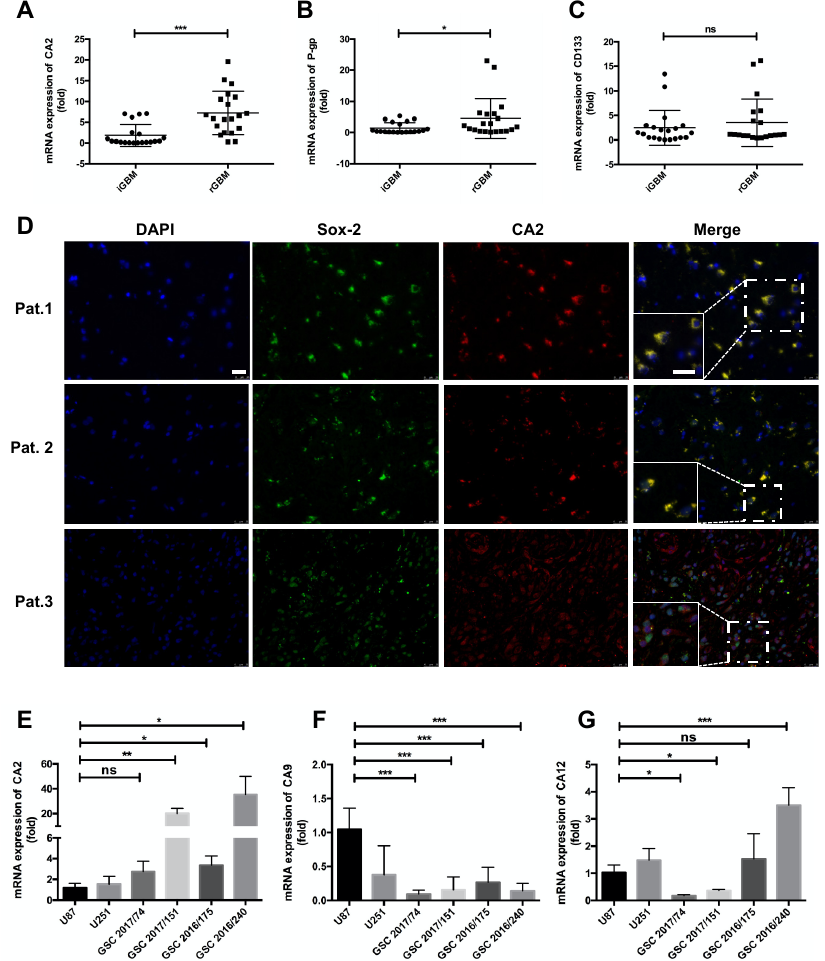
Figure 1. Expression levels of CA2 ( A ), P-gp ( B ), and CD133 ( C ) in patient-matched initial (i) vs. recurrent (r) GBM ( n = 20 from 10 matched patients); ( D ) Representative IF staining of CA2 and stem cell marker SOX2 in three GBM tissue sections. Co-staining of CA2 (red) and SOX2 (green) confirmed CA2 in stem-like cells of GBM patients ( n = 3 from 10 recurrent GBM patients), scale bar: 25 μ m. ( E – G ) mRNA expression of GBM related carbonic anhydrase genes CA2 ( E ), CA9 ( F ), and CA12 ( G ) in GBM cell lines U87 and U251 and patient-derived GSCs. Carbonic Anhydrase expression levels were detected by qPCR ( n = 3). For all genes, expression levels determined in U87 cells were set to 1. qPCR results were obtained from three independent experiments. In ( A – C , E – G ), data are presented as mean ± SD, student’s t -test was used to analyze ( A – C ), One-way ANOVA was used to analyze ( E – G ), * p < 0.05; ** p < 0.01; *** p < 0.001, ns: not significant. To characterize the function of CA2 in GBM cells by gain-of-function analyses, stable cell clones of U87 and U251 GBM cell lines were generated by transfection with either a control vector (U87_Ctrl and U251_Ctrl) or with a CA2 plasmid (U87_CA2 and U251_CA2). After selection with G418, stable cell clones were generated and analyzed for CA2 expres- sion by Western Blot and qPCR (Figure 2A,C), and one representative cell clone from each condition was selected for further analysis. U87_CA2 and U251_CA2 cells gave rise to a 29 kD band of CA2, whereas the control cells were negative for